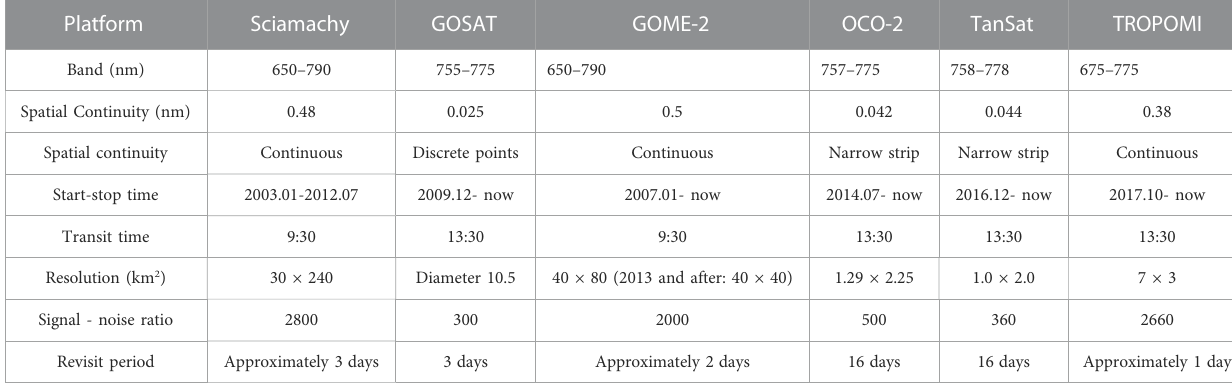
TABLE 3 Satellite-based sensors used to obtain SIF retrievals currently in orbit.